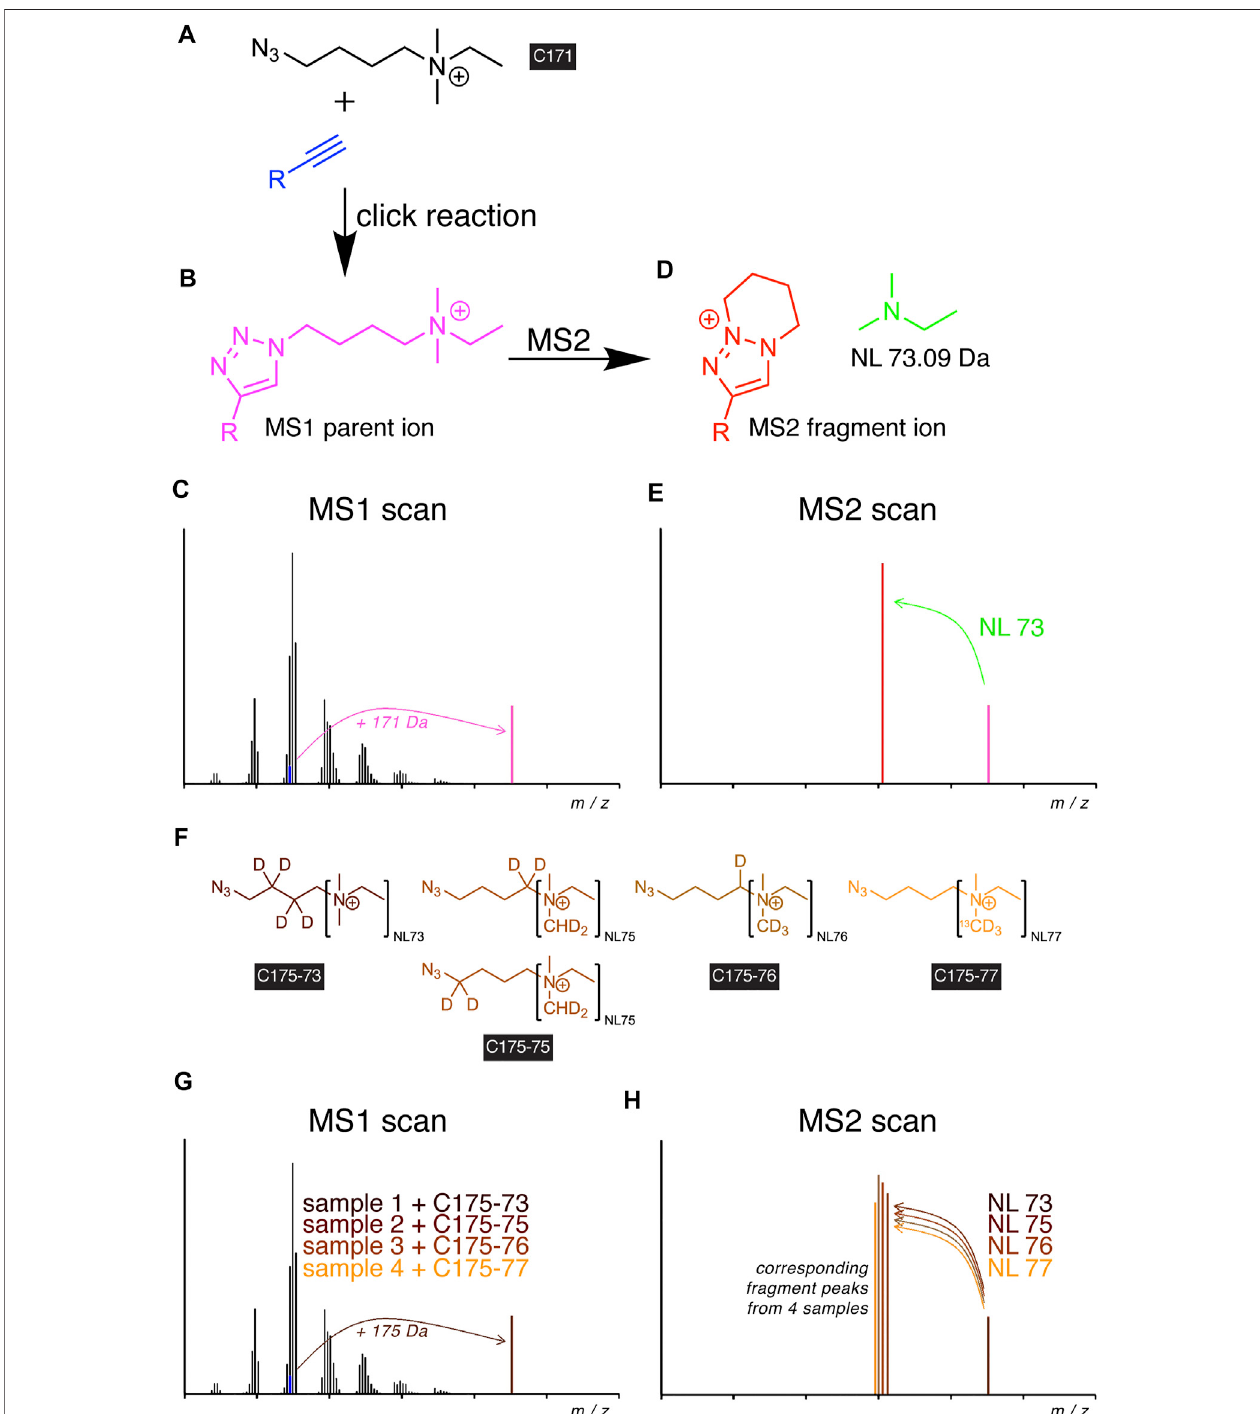
FIGURE 2 | Scheme of alkyne lipid detection by positive-mode DIMS using azide reporters. The C171 reporter (A) is click-reacted with an alkyne lipid (blue) to generate a mass-shifted product (B), discriminating its MS1 ion peak ( C , magenta) from unlabeled species of the same lipid class. MS2 fragmentation (D) yields a systematic neutral loss (NL, green) and generates a diagnostic fragment ion ( E , red), enabling the identi fi cation of the lipid analyte. For sample multiplexing, the related reporters C175-7x (F) are click-reacted to individual samples before sample pooling. The corresponding alkyne lipids from each samplegeneratea similarly mass- shifted product in MS1 scans (G) and are co-analyzed by MS2 but yield unique diagnostic fragment ions (H) .